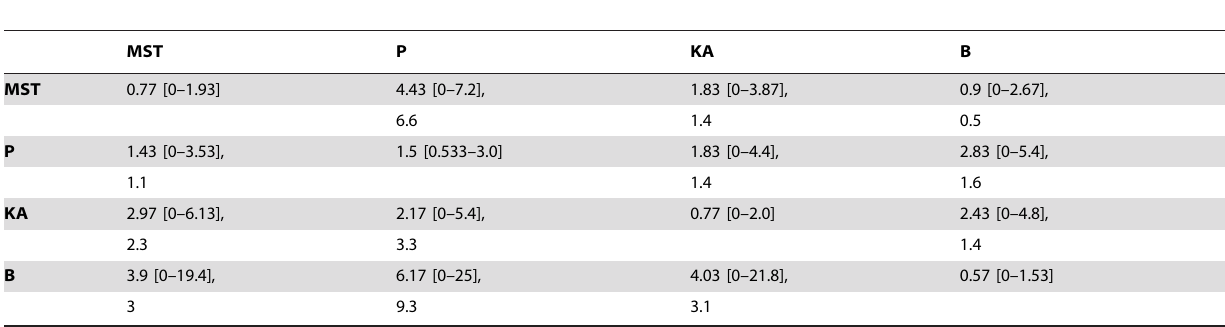
Table 6. Means of posterior distributions of mutation scaled immigration rate, M , along with the 95% confidence limits (before comma) and mean number of migrants per generation (after comma) estimated from Bayesian runs in